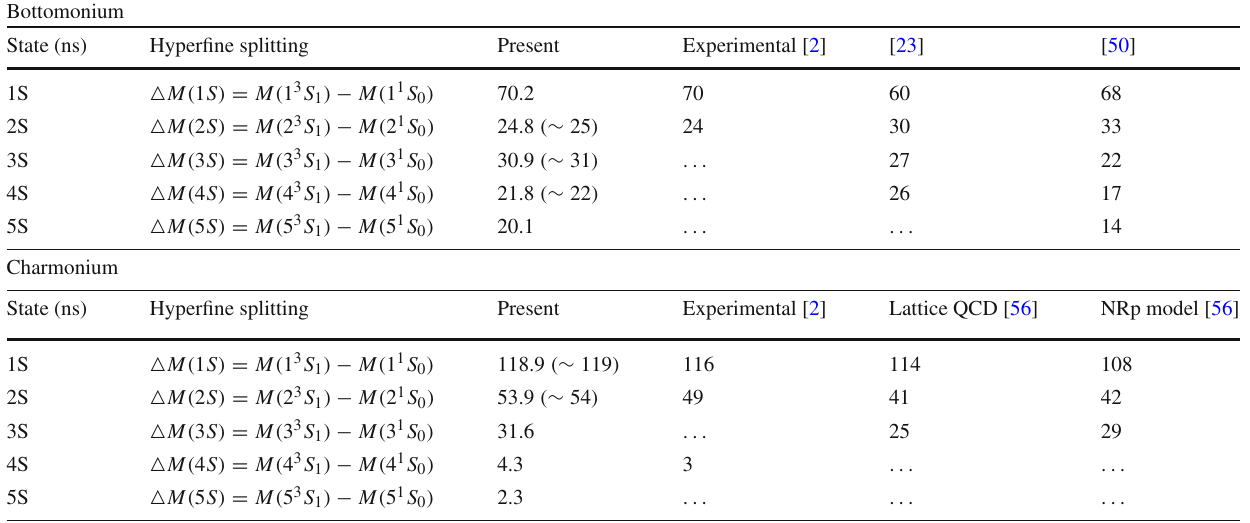
Table 6 The hyperfine splittings (in MeV) for S-wave bottomonium and charmonium Bottomonium State (ns) Hyperfine